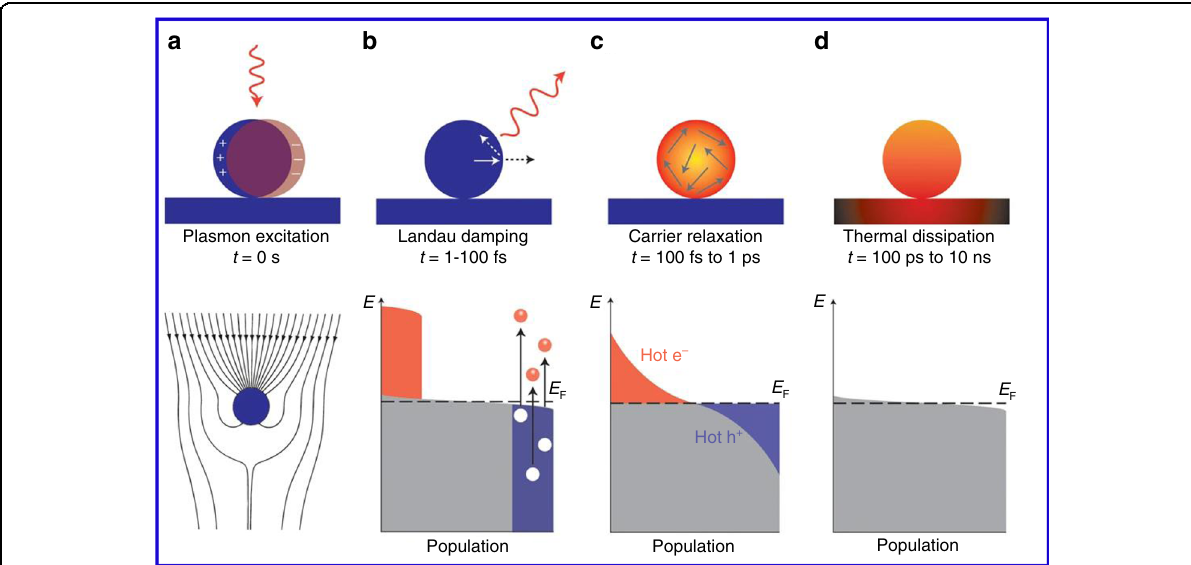
Fig. 15 A schematic representation of the plasmon excitation and dephasing in a metal nanoparticle and the characteristic timescale. a Photoexcitation of the local surface plasmons and enhanced light absorption. b HC generation through Landau damping (1 ‒ 100 fs) and their subsequent decay through photon re-emission or by carrier multiplication. c HC redistribute their energy quickly (100 fs ‒ 1 ps) through carrier – carrier scattering processes. d Finally, heat is transferred out of the metallic structure to the surroundings at a relatively long timescale (100 ps – 1 ns). Electronic states are represented by gray areas, the hot holes and hot electrons are presented in orange and purple colors, respectively. The fi gures are taken with permission from ref.